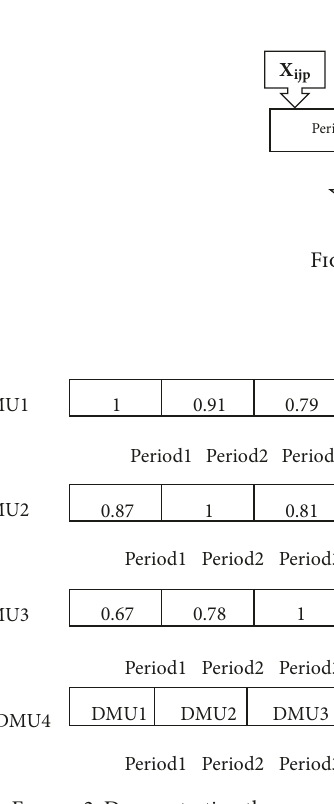
Figure 2: Demonstrating the proposed ideal DMU.